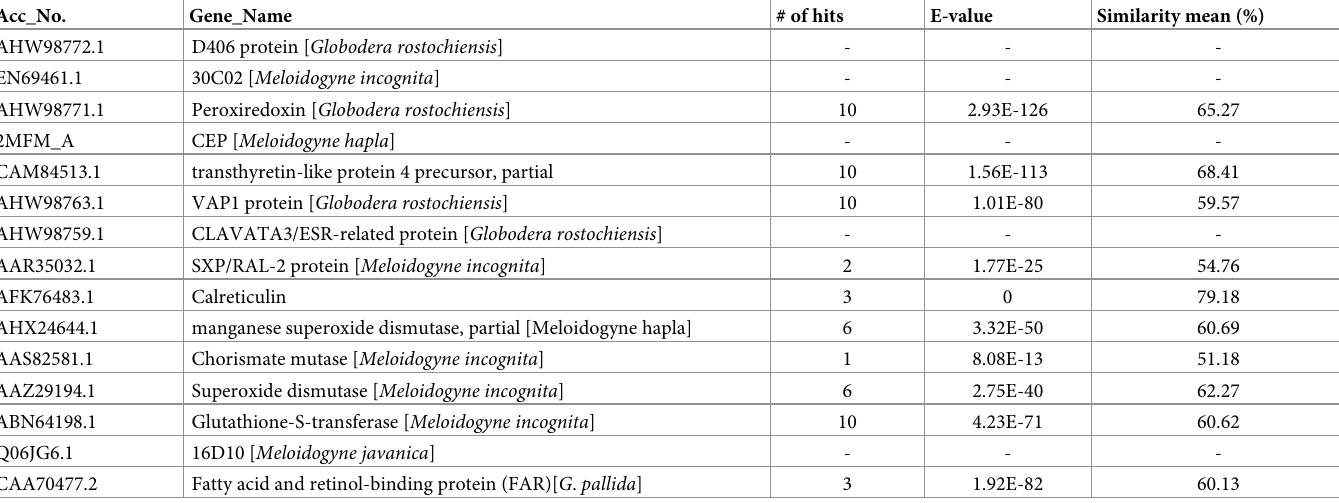
(Table B in S1 File). We noted that R . similis does not possess any homologues of the CLA- VATA3/ENDOSPERM SURROUNDING REGION(ESR), (CLE)—like peptides present in the cyst nematodes such as G . tabacum , G . rostochiensis and G . virginiae , which has been proven to be a required component to achieve development of a syncytium in host tissues [40]. Although we identified twelve genes predicted to encode for SPRY (SP1a and RYanodine receptor) domains, these putative SPRY-containing proteins lack a secretion signal, which is an essential requirement for the protein to be classified as a SPRYSEC ‘effector’. The presence of proteins with SPRY domains has been confirmed in the R . similis transcriptome analysis as well [41]. Within PPNs, proteins with SPRY domains and a secretion signal (SPRYSECs) have only been found in cyst nematodes and have been shown to be involved in suppressing and eliciting defense response in the host plants[42]. This absence of SPRYSEC effectors is consistent with R . similis not forming elaborate feeding sites in roots. However, effectors associated with host defense induction such as venom allergen- like effector proteins (VAPs) and suppression such as calreticulin (3) were present in R . similis [43,44] and one of these predicted calreticulins also possesses an ER-retention signals. Within PPNs, calreticulin has been extracted from the gland secretions of the root-knot nematode, M . incognita and the migratory PPN, B . xylophilus , where it has been shown to be involved in host defense suppression and reproduction respec- tively [43,45]. Homologues of genes involved in protection against host-derived oxidative stresses such as superoxide dismutase, peroxiredoxin, glutathione-S-transferase and glutathi- one-peroxidase were also found in R . similis (Table 1).Homologues of the S-phase kinase-asso- ciated protein, involved in ubiquitination pathways as well as the FAR-1 / SEC-2 , involved in the circumvention of host defense were also identified in R . similis [46,47]. R . similis also pos- sesses a gene coding for a putative secreted chorismate mutase (with ~51% similarity), which is a key enzyme involved in modification of the host salicylic acid pathway [48]. A variety of pro- teases found in a broad spectrum of nematodes (irrespective of lifestyle) such as serine car- boxypeptidase, cathepsin S, B and L were also identified in R . similis (Table B in S1 File). No homologues of the putative apoplastic effector 4D06 or the putative parasitic stage effector 30C02 or the plant peptide hormone mimic C-terminally Encoded Peptide (CEP) was found in the R . similis predicted protein set, further underscoring the lifestyle difference between a sedentary and a migratory PPN (see Table 1). Table 1. Blast analysis of some known parasitism genes against R . similis predicted protein set.